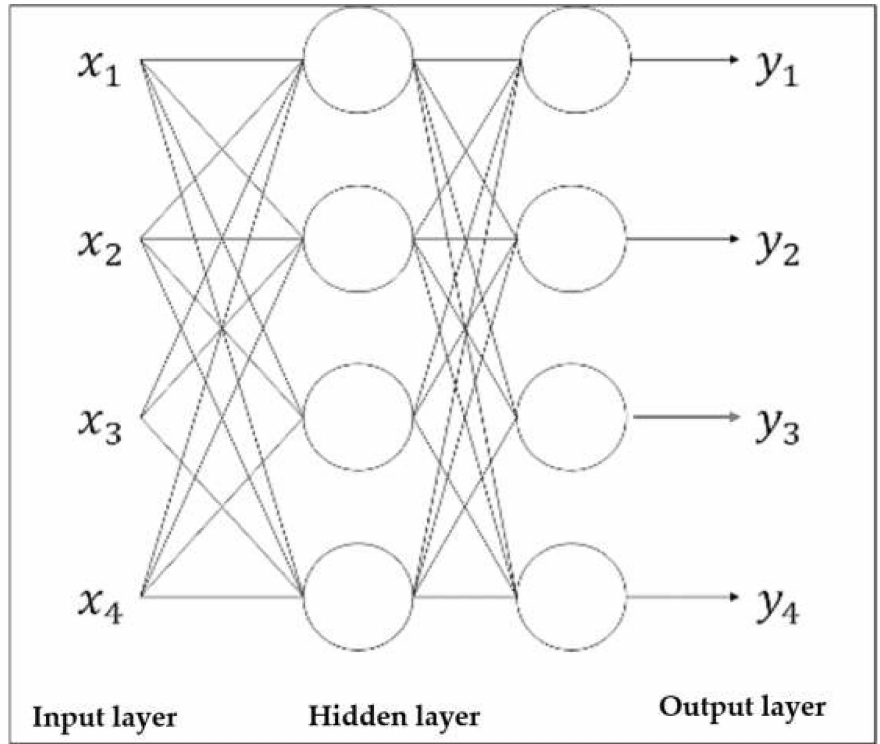
Figure 2. Schematic diagram of the deep neural network